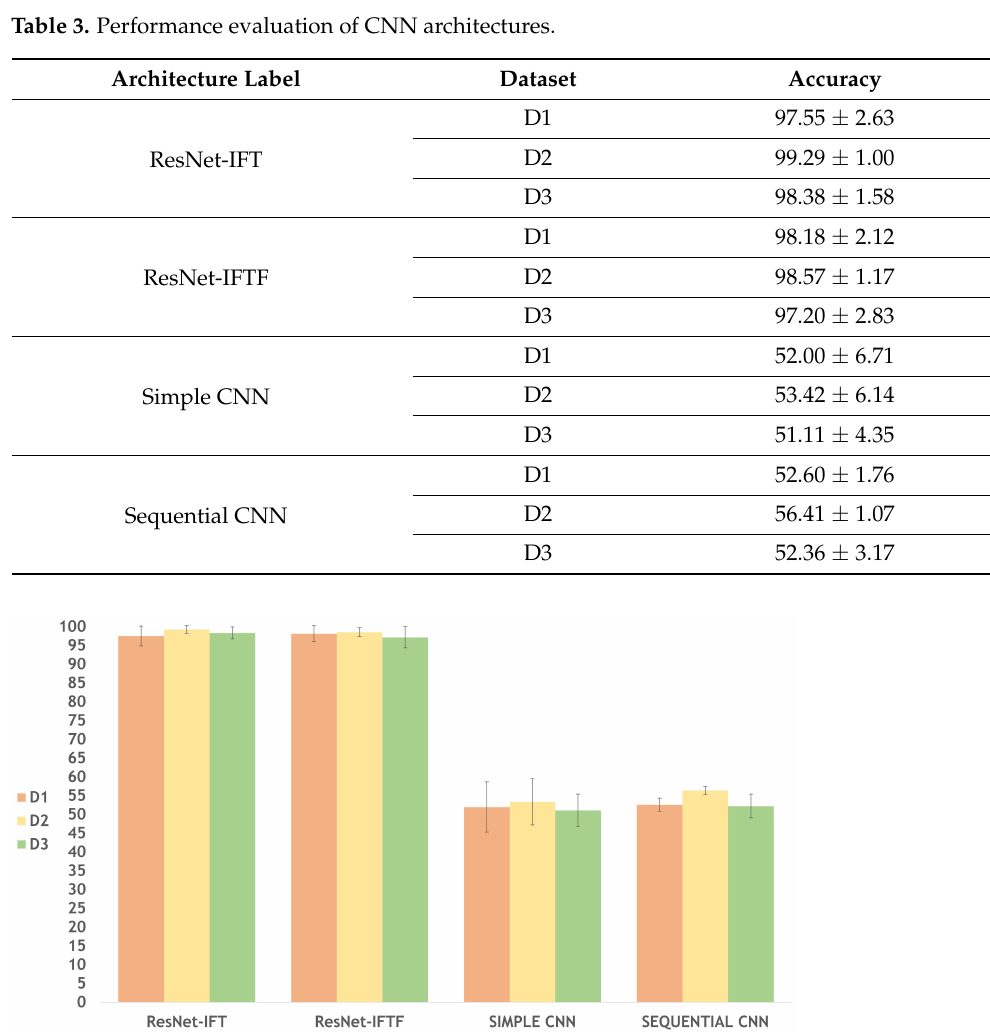
Figure 6. Accuracy performance per architecture. The ResNet-IFT and ResNet-IFTF architectures reach an accuracy between 97.2% and 99.29%; however, ResNet-IFT gives the best performance for 2 of the 3 datasets developed for this